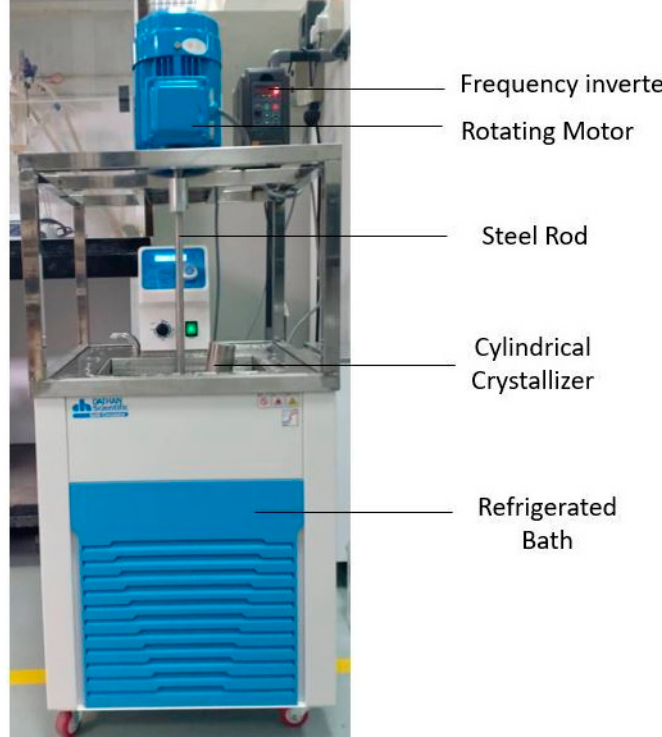
Figure 3. Experimental setup for progressive freezing via a circular moving cylindrical crystallizer.